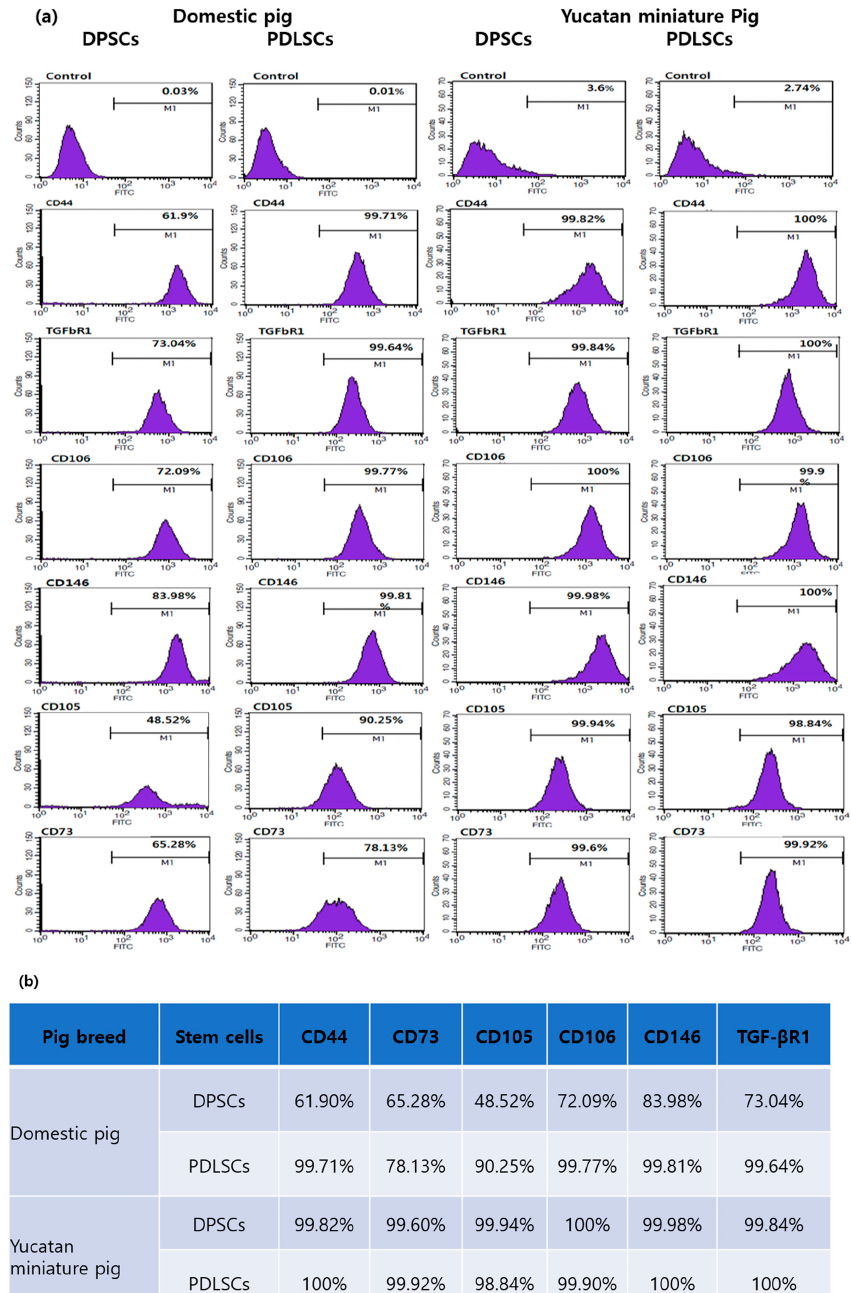
Figure 3. Fluorescence-activated cell sorting (FACS) data of the dental pulp stem cells (DPSCs) and periodontal ligament stem cells (PDLSCs) of the miniature pig breed and the domestic farm pig breed: ( a ) representative figures of the cytometric flow test; ( b ) percentages of positive expression (mean data). The stem cell populations of the pigs in this study exhibited high expression patterns for CD44, TGF- β R1, CD106, CD146, CD105, and CD73 for positive